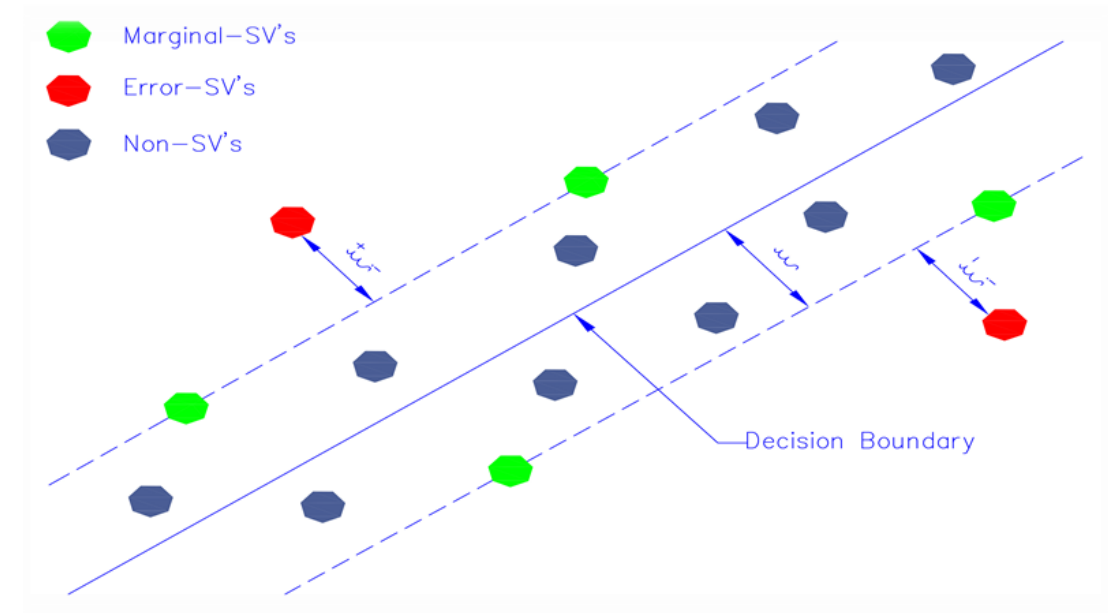
Figure 6. Basic structure of SVR model.